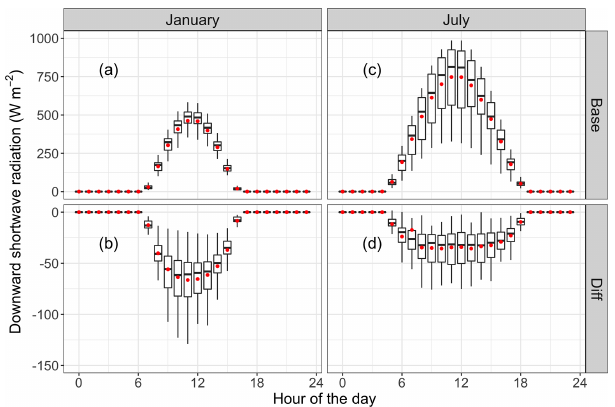
Figure 2. Diurnal variances of SWDOWN (a, c) and the impact of ADEs on SWDOWN (b, d) , in January and July 2013. The central rectangle spans the first quartile to the third quartile. The segment and red dot inside the rectangle show the median and mean value, respectively. The whiskers above and below the box extend to the highest and lowest values.